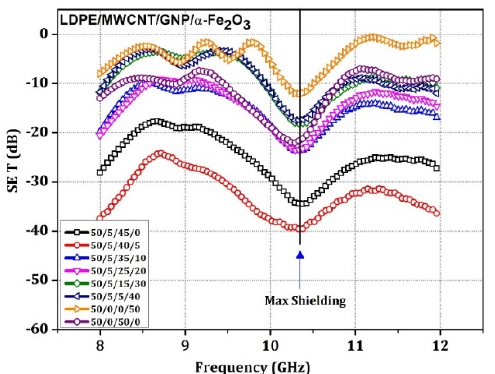
Figure 6. The SE T vs. frequency for a sample of 3.5 mm thickness LDPE: MWCNT: GNP: α‐ Fe 2 O 3 matrix nanocomposite specimen.